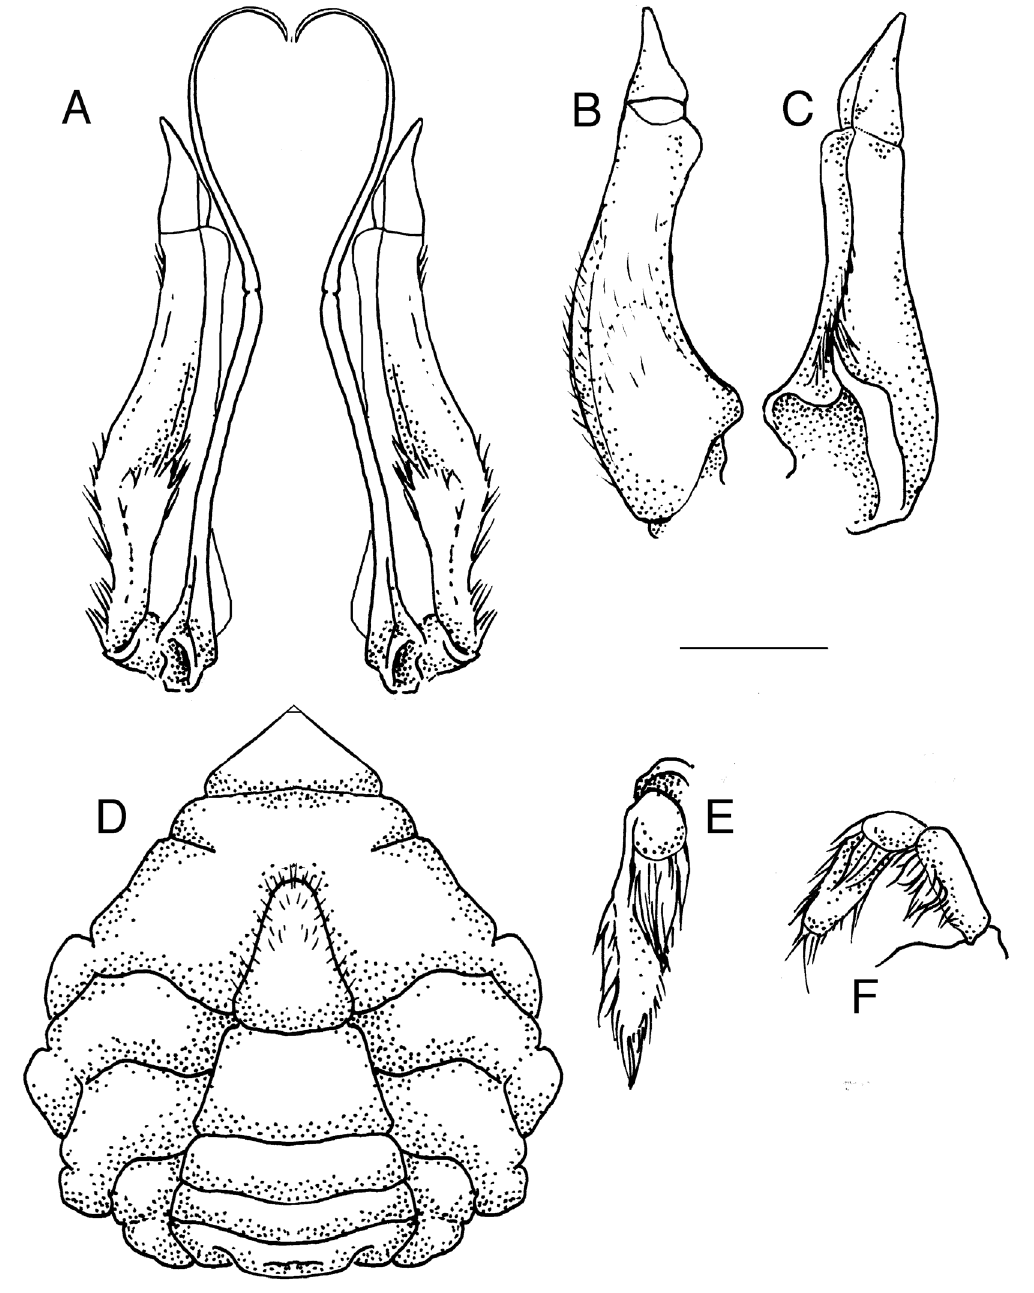
Fig. 2. Foza manonae sp. nov. Holotype, adult ♂, CW 43.7 mm, Ankarana Special Reserve, Madagascar (ZSM A20145003). A . Left and right G1 and G2 shown in situ in ventral view. B . Left G1, dorsal view. C . Left G1, ventral view. D . Sternum and abdomen, ventral view. E . Left mandibular palp, superior view. F . Left mandibular palp, frontal view. Scale bar: 14 mm (A–B, E), 23.2 mm